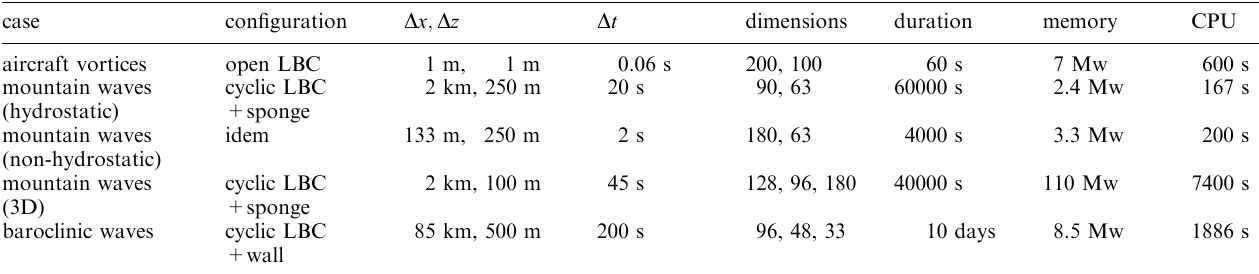
Table 1. Some characteristics of the control simulations. The CPU time is measured on a single Cray C90 processor case configuration